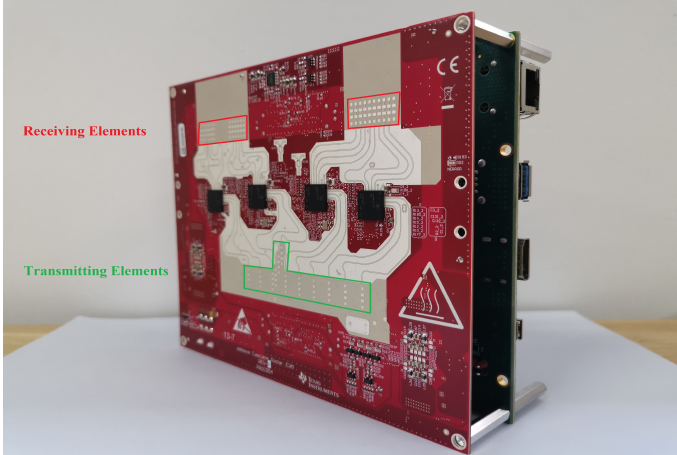
Figure 1. TI Cascade FMCW MIMO Radar